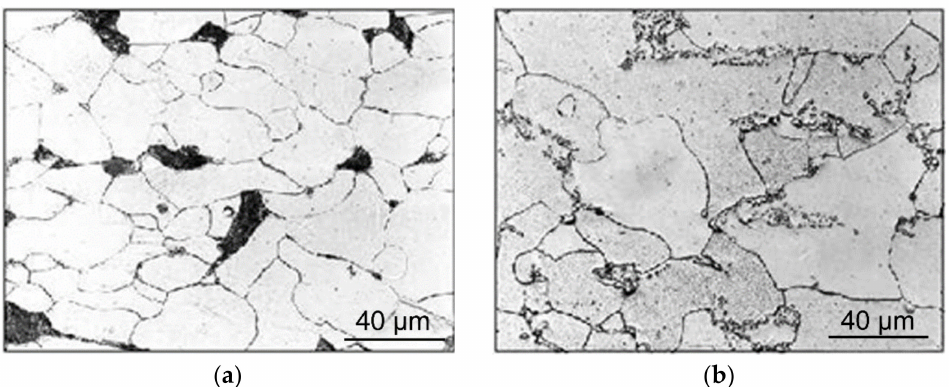
Figure 3. OM images of structure of TRISTAL steel: before spheroidising annealing ( a ); after spheroidising annealing ( b